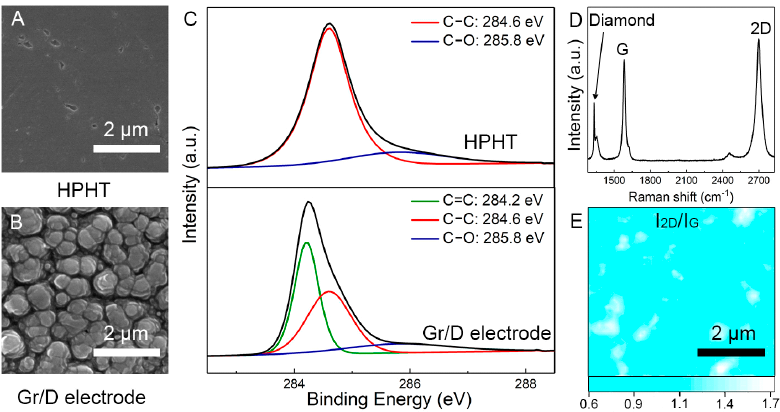
Figure 2. ( A , B ) SEM images and ( C ) XPS spectra of the high pressure high temperature (HPHT) and G/D electrode. ( D ) Raman mapping profile of I 2D /I G in a 5 × 5 µ m area. ( E ) A typical Raman spectrum of G/D.